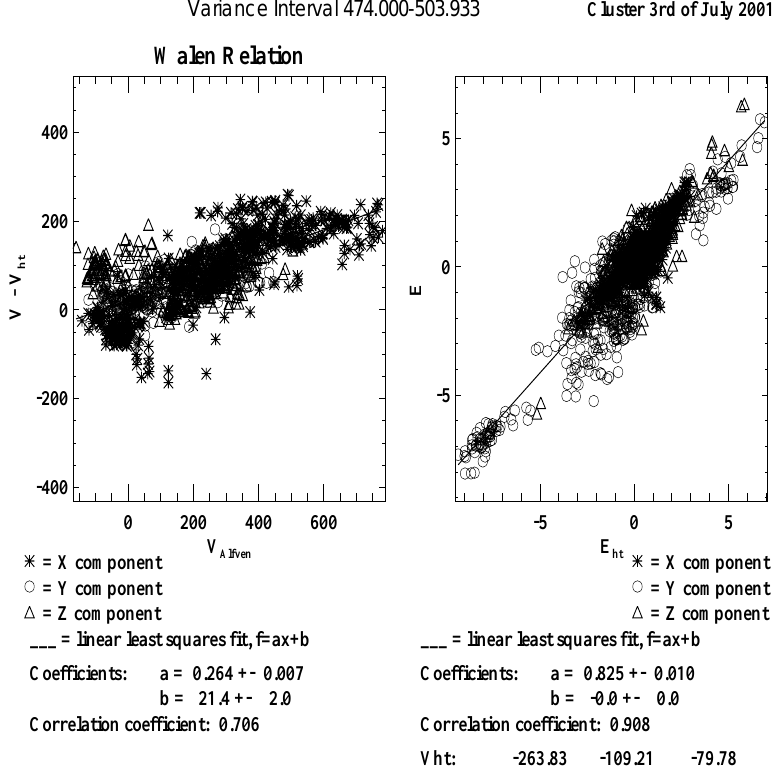
Fig. 15. Wal´en relation (left) and deHoffmann-Teller frame (right) between 07:54–08:24 UT measured by sc3.